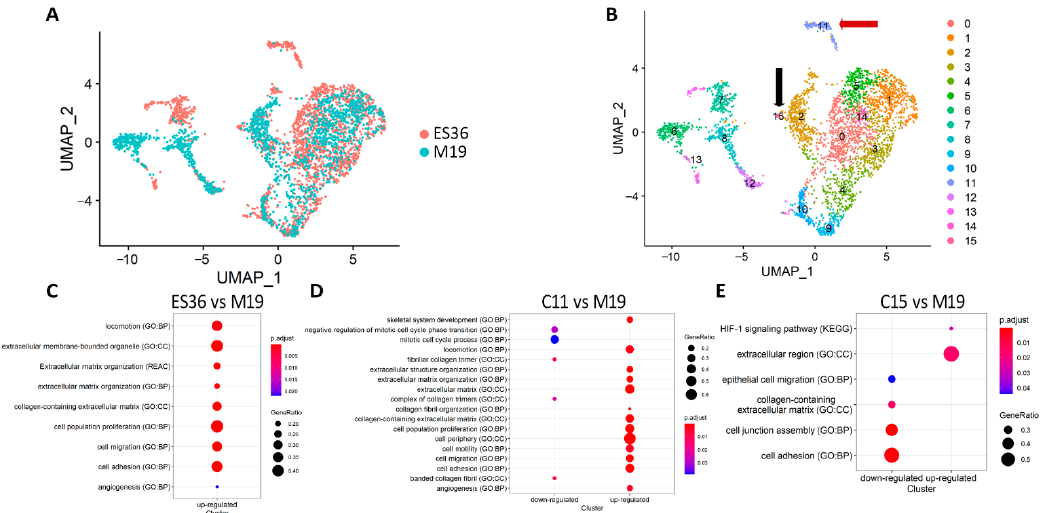
Figure 2. UMAPs of single-cell transcriptome data. Quality control filtering of embryonic fibroblasts ( A – E ) and ES36 tumor sample ( F – J ) . Comparison of 10× Genomics-annotated doublets, singlets, and negatives was assessed using gene expression that was log-transformed using Seurat and presented as violin-box plots with highlighted median values. Violin plots showing the counts of each gene in each cell ( A , F ). Violin plots of the sum of the expression levels of all genes in each cell ( B , G ). Violin plots of the percentage of mitochondrial genes ( C , H ). Scatter plots for the percentage of mitochon- drial genes in the sum of the expression levels of all genes in each cell ( D , I ). Scatter plots for the counts of genes ( E , J). Embryonic human fibroblasts ( K ) and patient-derived ES ( L ) color-coded by cell identity. Colors show different cell clusters resulting from UMAP clustering using the SEURAT algorithm. The multiple sequencing runs from M19 and ES36 cells were combined into a single uniform manifold approximation and projection (UMAP) for visualization (Figure 3A)